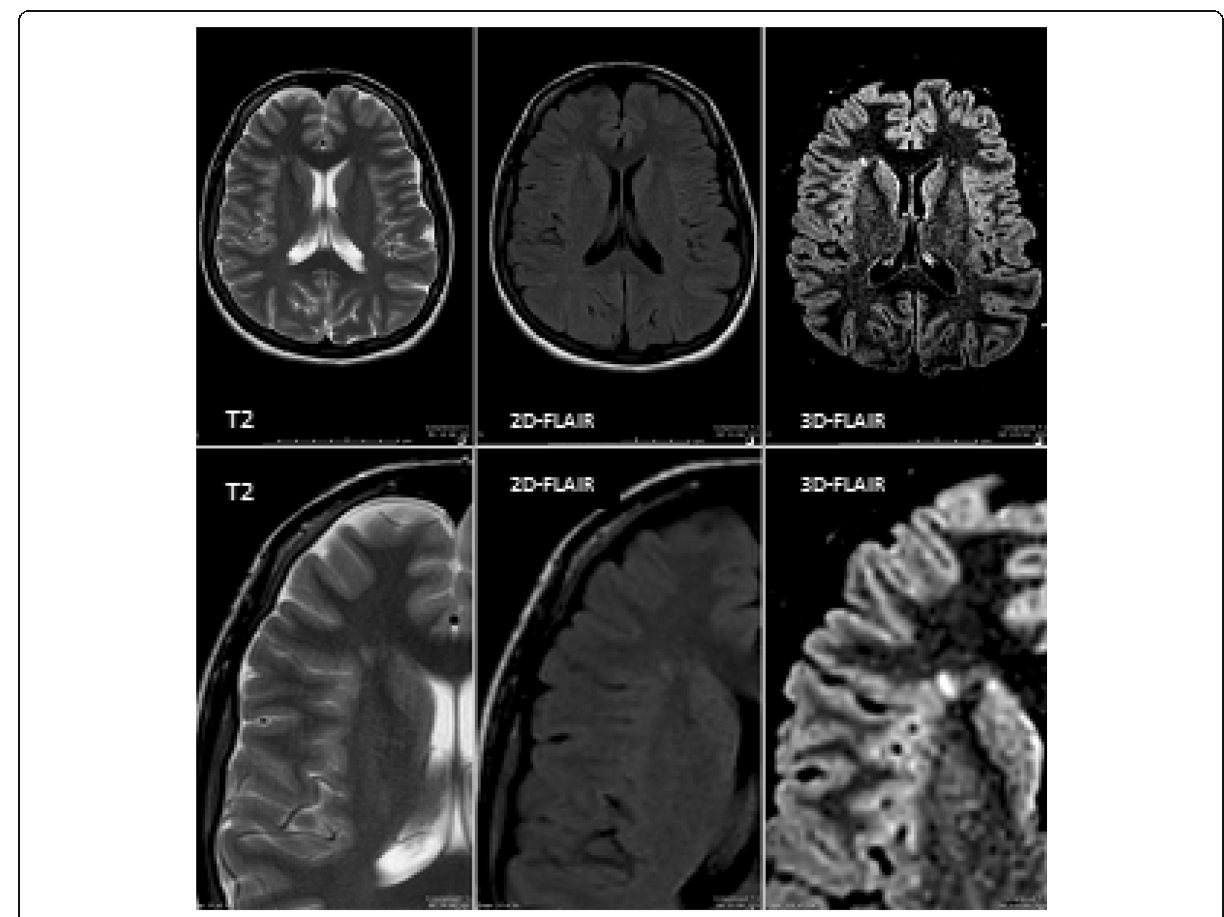
Fig. 6 Above row axial T2, 2D FLAIR, and 3D-FLAIR image and below row is detail enlargement approximately corresponding to above images showing single hyperintense lesion seen in juxta-cortical white matter; it is better seen on 3D-FLAIR images with good contrast to both white and grey matter and less depicted on T2 and 2D-FLAIR